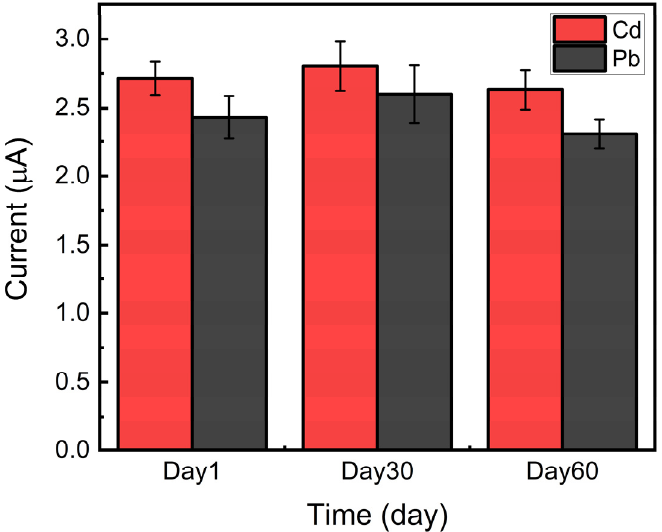
Figure 8. Reproducibility and stability test, using five different HPC electrodes for a two-month period (red bar, 200 ppb Cd; black bar, 200 ppb Pb).